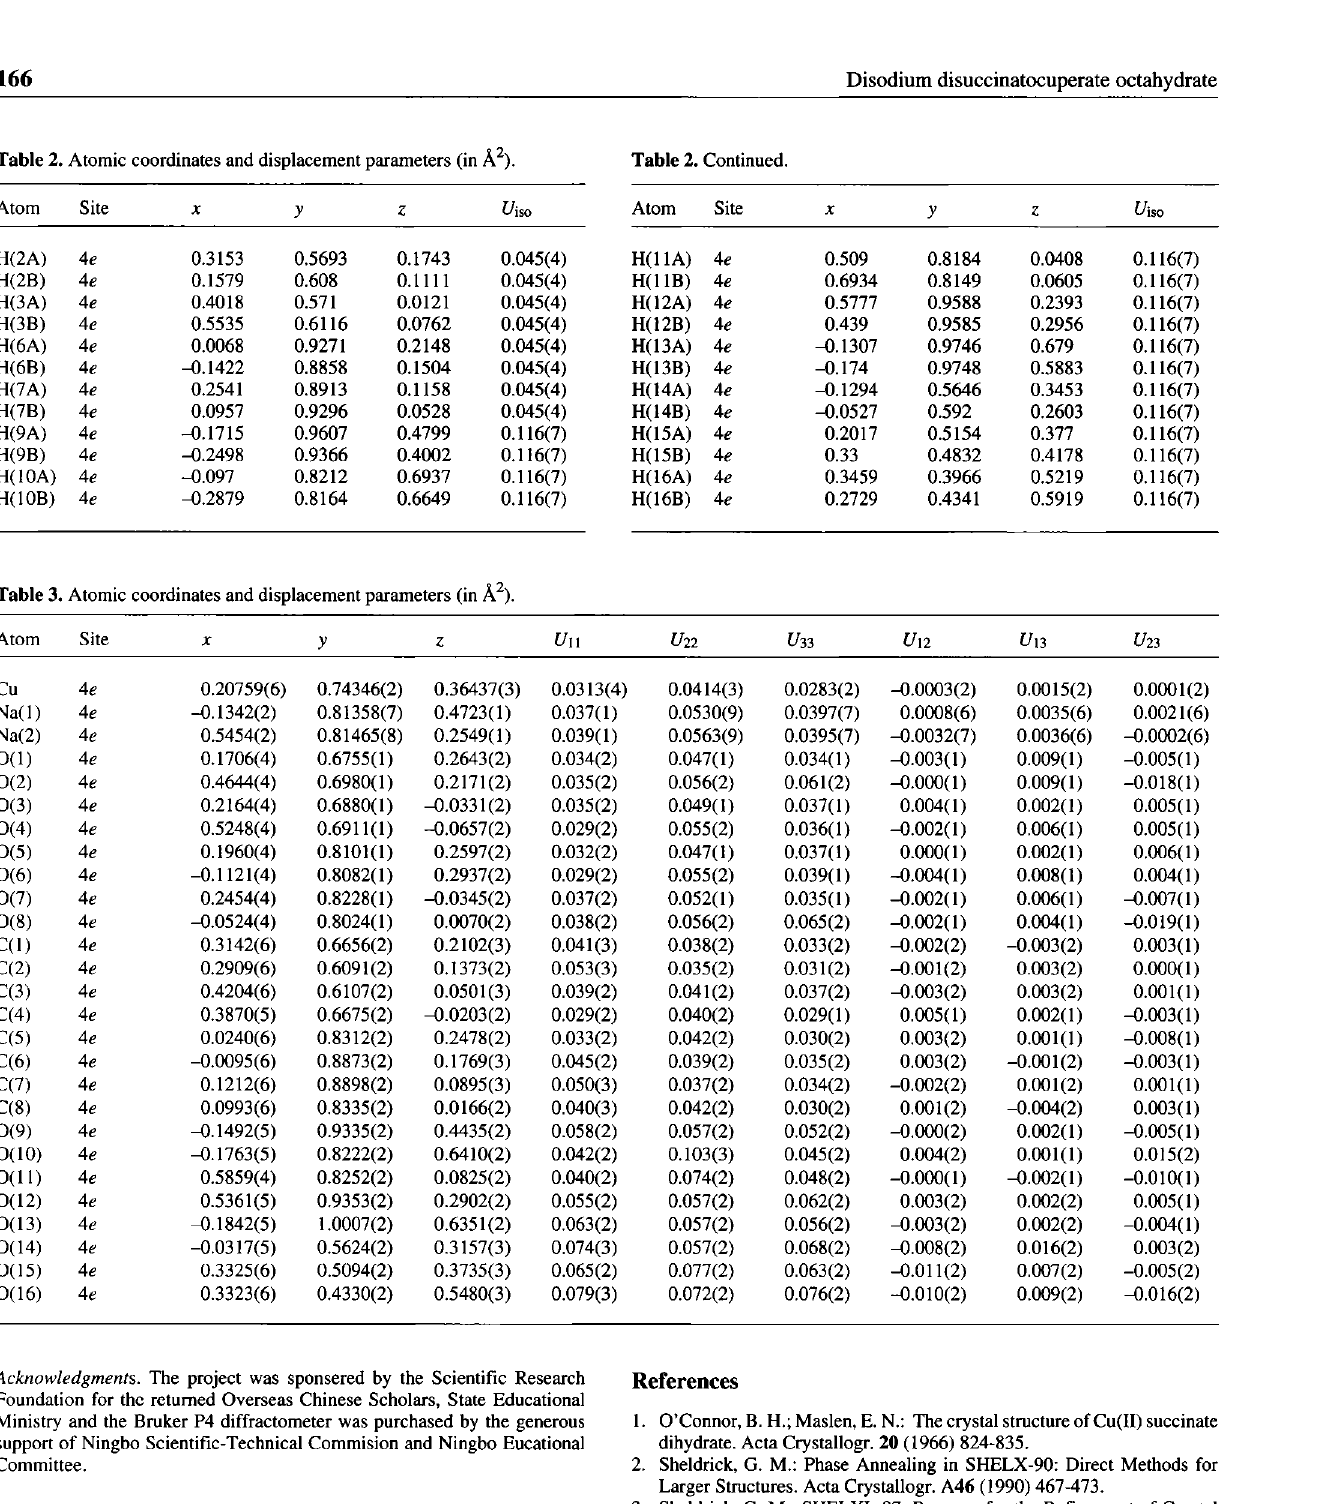
Table 2. Atomic coordinates and displacement parameters (in Ä 2 ).